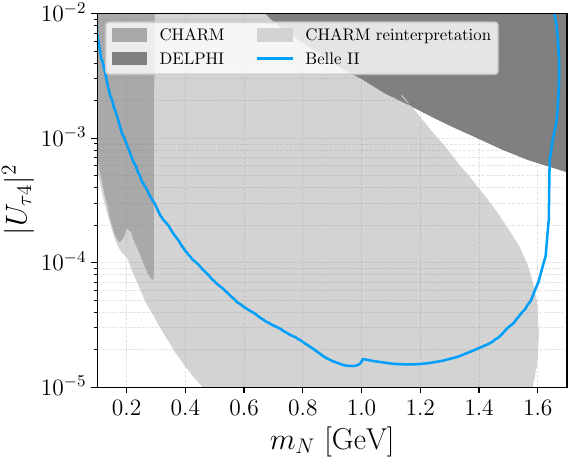
Figure 7 . Expected sensitivity limits on the mixing matrix element squared, | U τ 4 | 2 , as function of the sterile neutrino mass, for the minimal scenario. The dark and medium gray areas correspond to the parameter regions currently excluded by DELPHI [34] and CHARM [29, 30], respectively. A recent re-interpretation [84] of the CHARM experiment results [29, 85] further excludes the light gray parameter region. The kink at m 1 GeV is due to the ρ -threshold in the τ -decay. N ∼